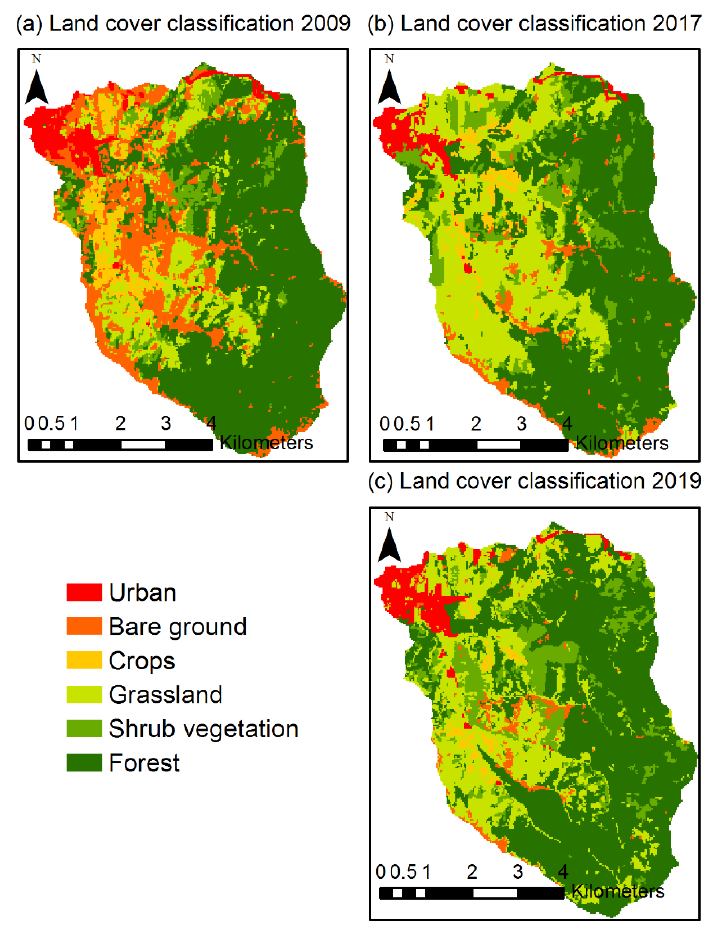
Figure 2. Land cover maps classified for years ( a ) 2009, ( b ) 2017, and ( c ) 2019.